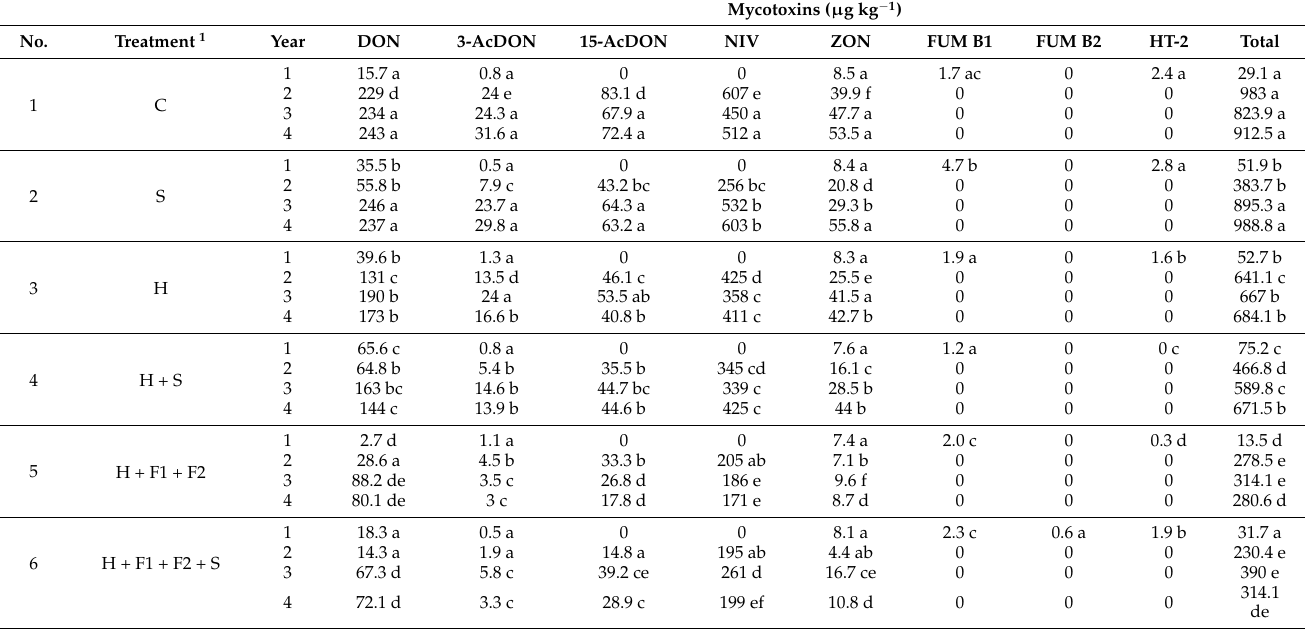
Table 3. Mycotoxins concentration in diverse strategies of crop protection in four years of the study (1—2017; 2—2018; 3—2019; 4—2020). The same letter in the particular year of the study indicates that the value is not significantly different ( p ≥ 0.05).